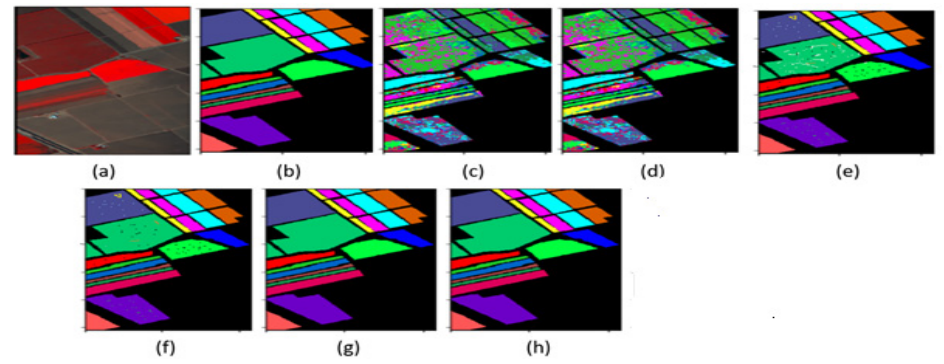
Figure 7. Indian Pines classification maps. ( a ) RGB image; ( b ) ground truth; ( c ) 2D–3D CNN; ( d ) SSRN; ( e ) ResNet; ( f ) DenseNet; ( g ) e-CNN; and ( h ) CNN–EEHO–AdaBound.